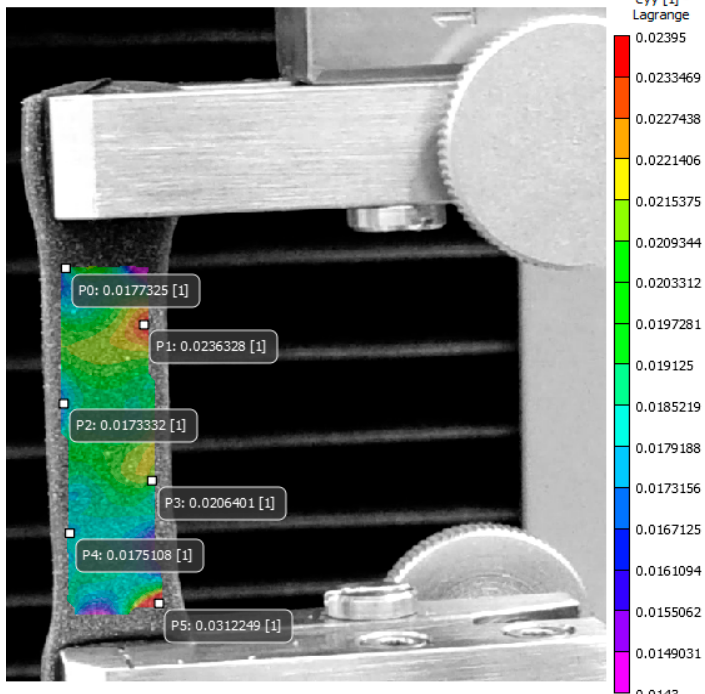
Figure 6. Strain distribution measured using DIC during the tensile test (at t = 1 s) on the biofidelic human skin specimen with no wound.